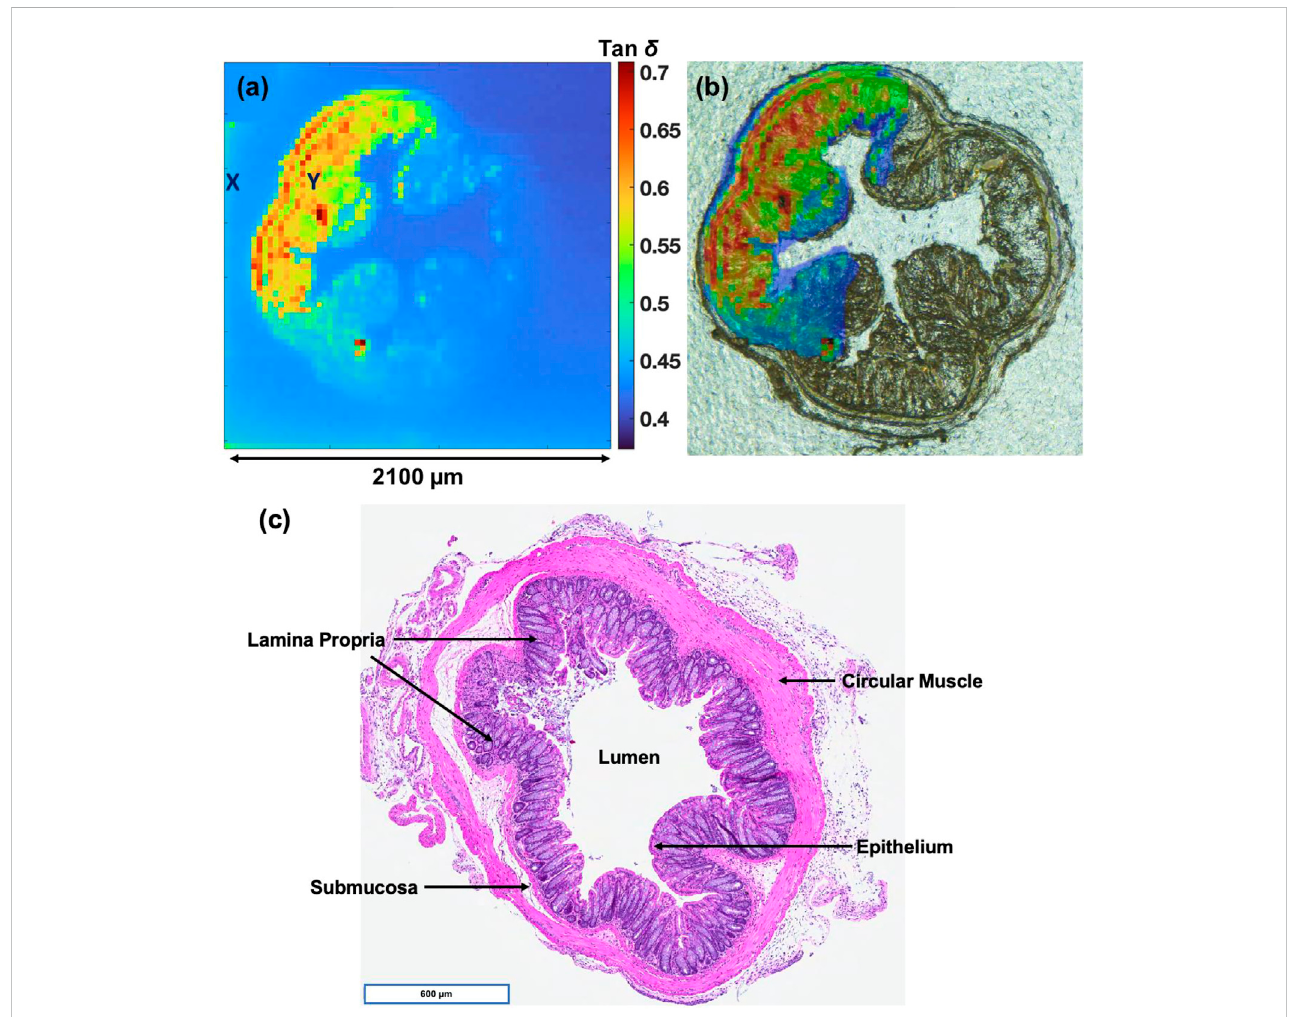
FIGURE 2 (A) Tan δ map of a deparaf fi nized mouse colon section. Frequency vs. impedance measurements were performed on the glass substrate ( X ) and colon section ( Y ). (B) An overlay of Tan δ and bright fi eld image of the colon section. (C) H&E stained section derived from the same mice